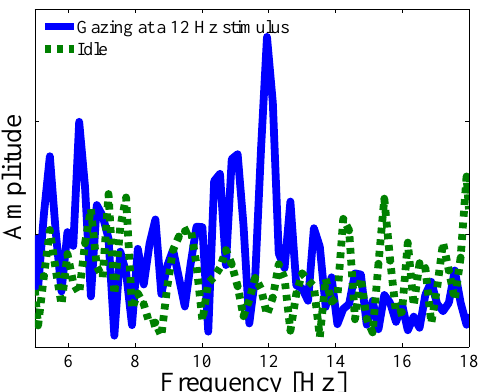
Figure 8. Example of an SSVEP: Power spectrum of the signal observed when a subject gazes at a visual pattern (flickering at 12 Hz) compared to the power spectrum of the signal observed when the subject does not receive any stimulus